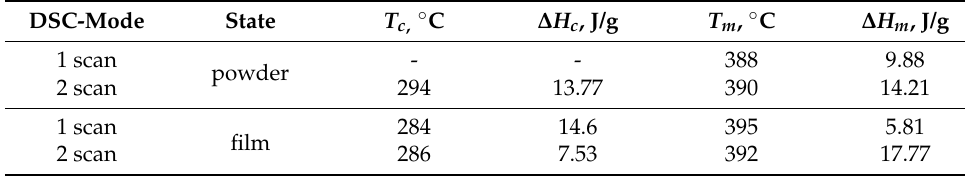
Table 3. DSC crystallization data for sample PI-BPDA.